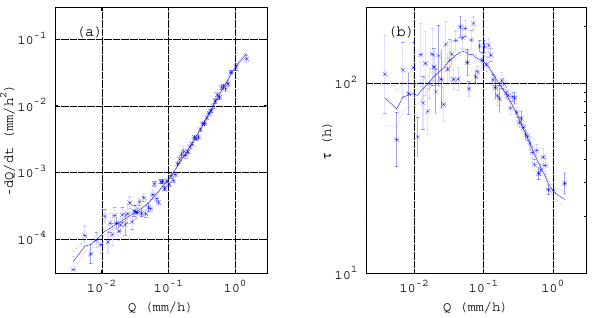
Fig. 3. (a) Binned mean hourly − ˙ Q vs. Q for the same exam- ple site as in Fig. 2, together with the piecewise linear functional smoothed fit (middle line). Error bars are standard errors for each bin; upper and lower lines show uncertainty of fit ( ± 1 standard error). (b) Binned mean recession time τ vs. Q for sample site, together with the piecewise linear smoothed fit (error bars are stan- dard errors for each bin; upper and lower lines show fit uncertainty as ± 1 standard